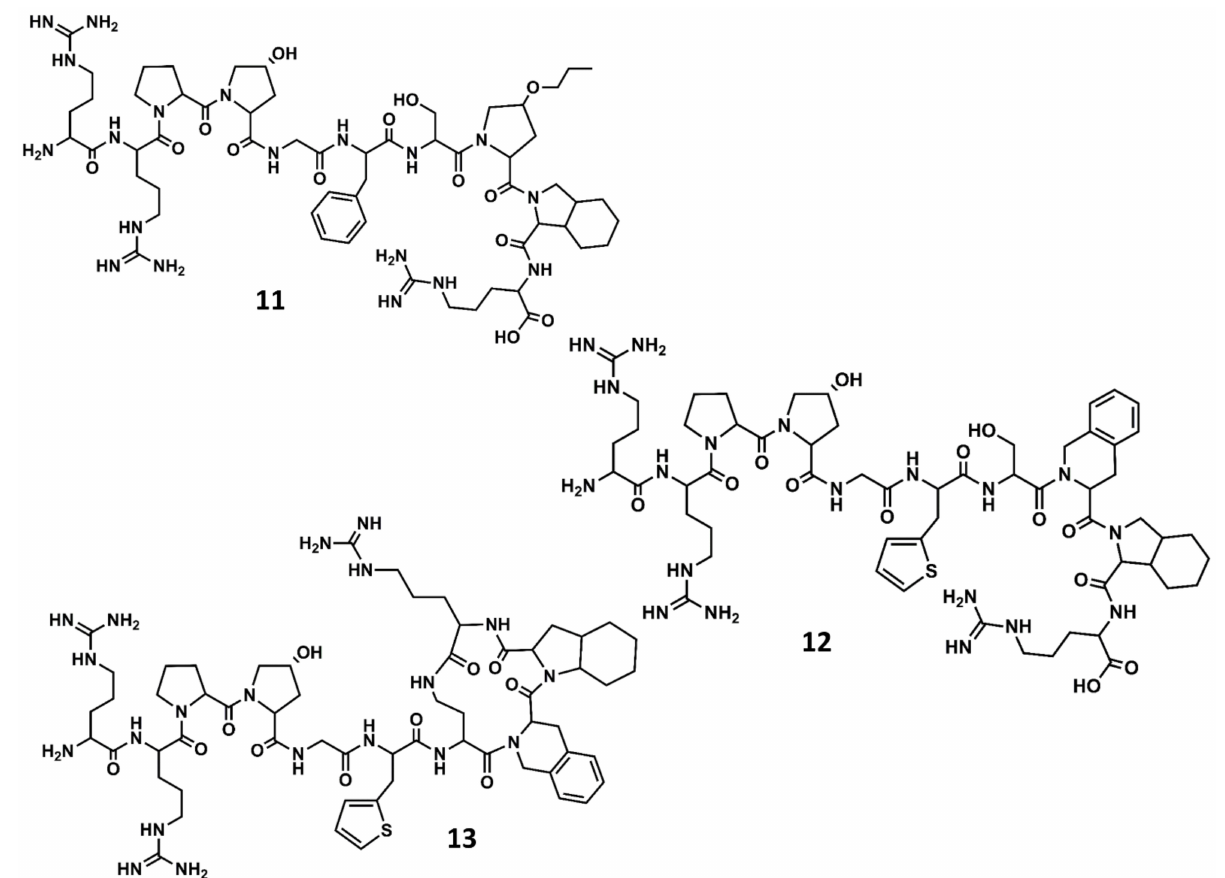
Figure 7. Chemical structures of diverse conformationally constrained B2 antagonists: NPC17731 ( 11 ); icatibant ( 12 ) and MEN11270 ( 13